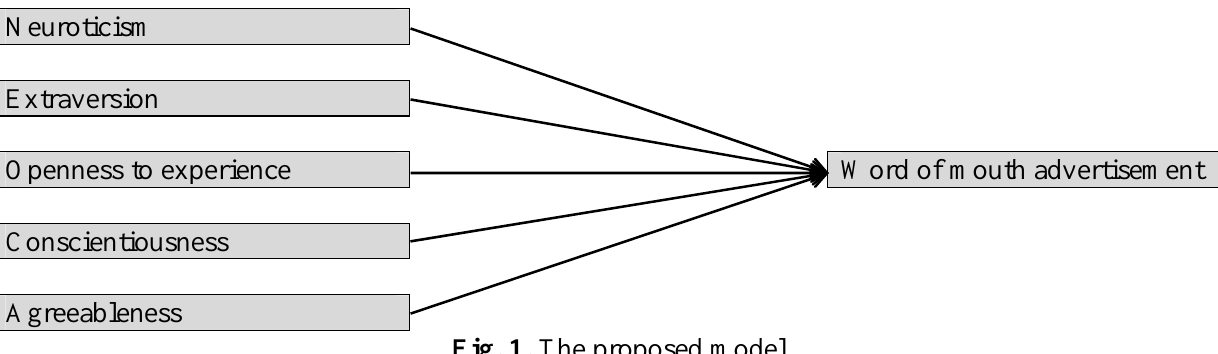
Fig. 1. The proposed model